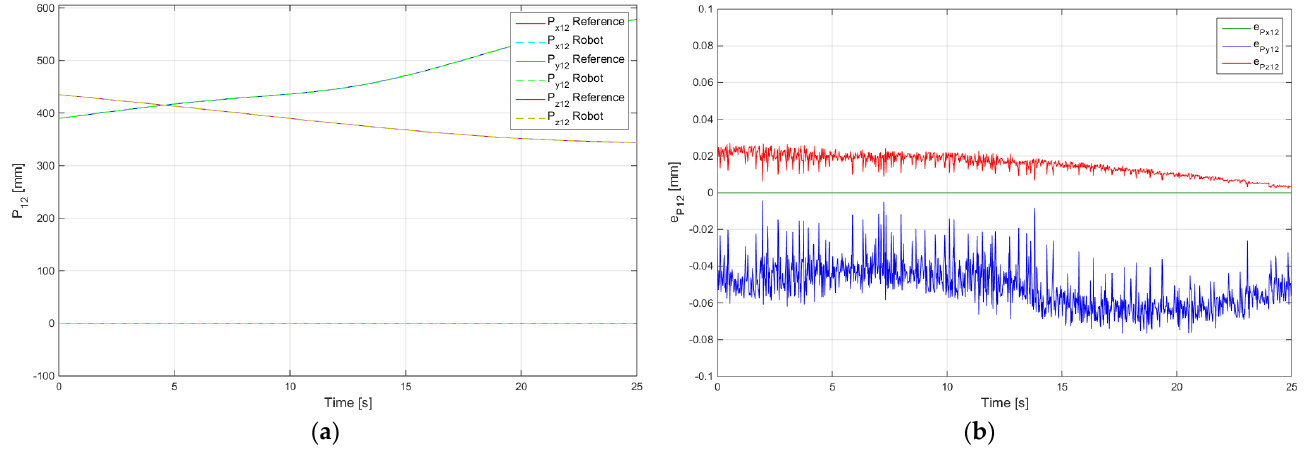
Figure 11. Simulation results ( a ) variation of the end-effector position along the Ox , Oy and Oz axis ( b ) variation of the absolute error. The obtained MAE errors during the simulation were: 0 mm for P x 12 position, 0.051 mm for P y 12 position and 0.0151 mm for P z 12 position. These values were in the same range as the imposed e re , and were characterized by slight random fluctuation around e re . The imposed trajectory (blue) and the simulation results (red) for the end-effector positions are presented in Figure 12a. The end-effector position error e T is presented in Figure 12b. The obtained MAE, 0.0537 mm and 0.006%, represents the method error (S-GUIDE algorithm) for a preset input parameters ( e bz = 0.5 mm e re = 0.05 mm) and for an ideal robot (without joint errors, structure bending and torsion etc.).